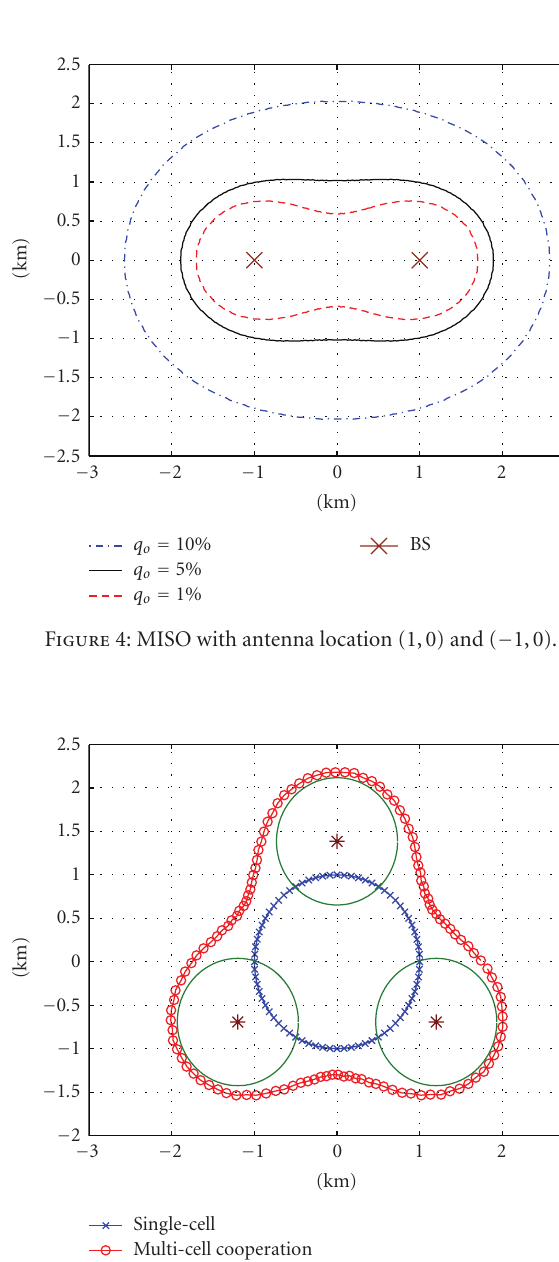
distance between two base stations is doubled. Compared